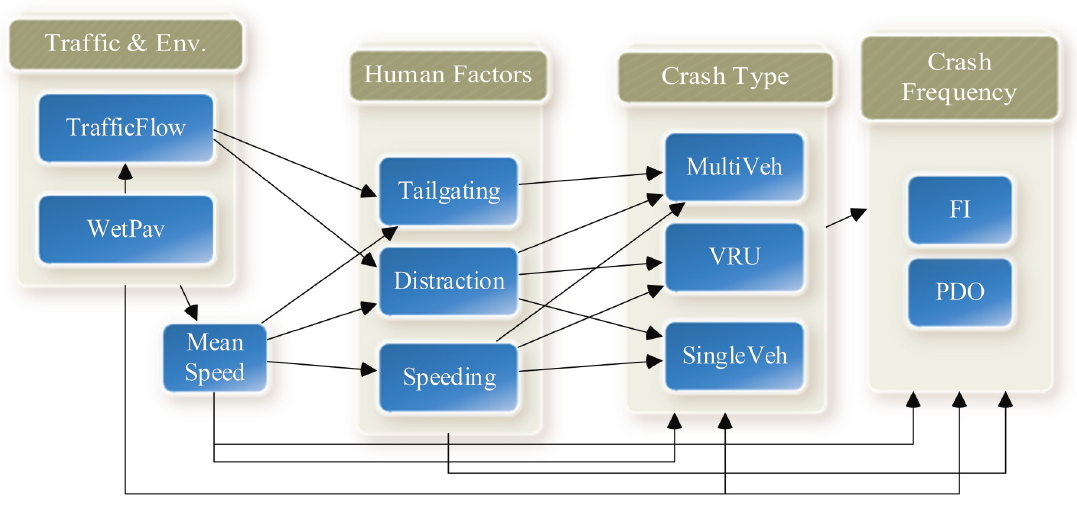
Fig 3. Conceptual